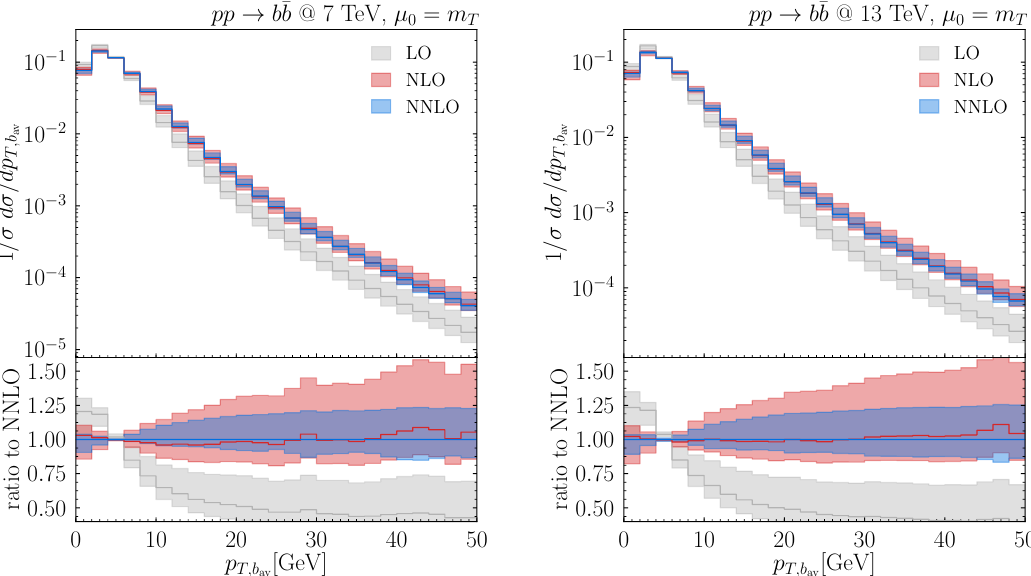
Figure 7 . Normalised transverse momentum distribution of the bottom quark at the LHC for p s = 7 TeV (left) and 13 TeV (right). The lower panels show the ratio to the NNLO prediction.